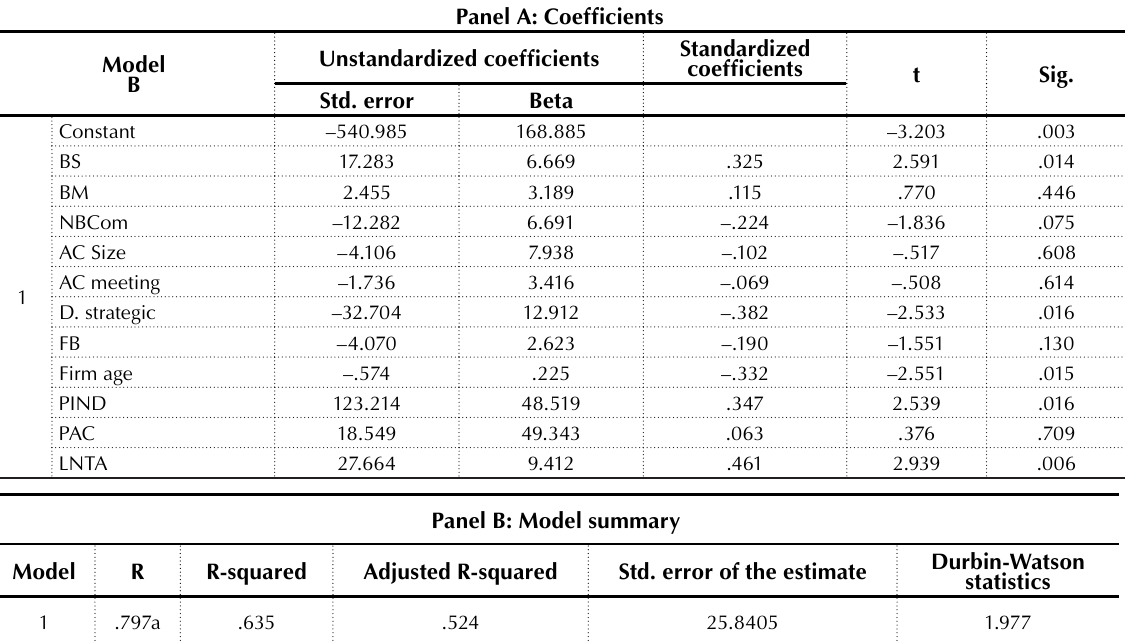
Table 7. Regression results – Dependent variable – Tobin’s